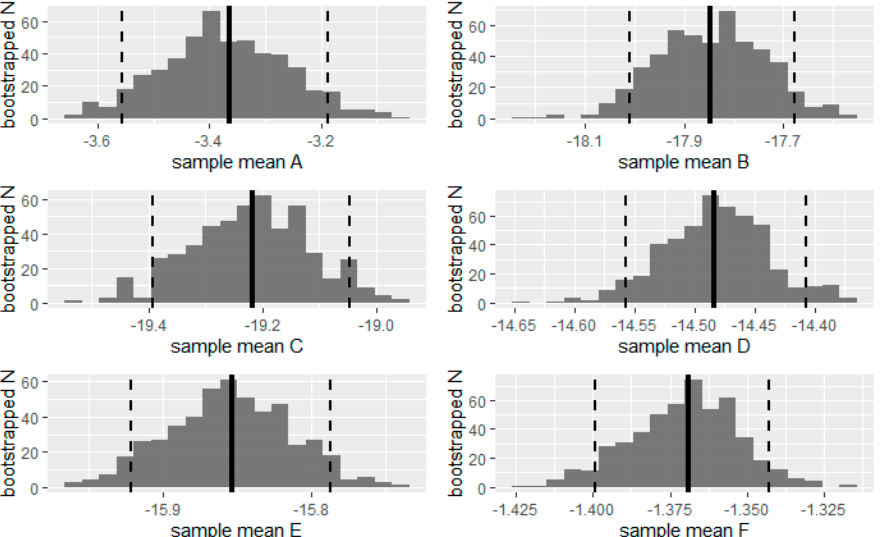
Figure A5. Histogram plots mean differences between each pair of observer profiles (( A ) garden-watcher vs beginner; ( B ) garden-watcher vs naturalist; ( C ) garden-watcher vs expert; ( D ) beginner vs naturalist; ( E ) beginner vs expert; ( F ) naturalist vs expert) obtained by 500 bootstraps of the original samples. Dotted lines are the confidence interval boundaries ( p = 0.05) and the central line is the initial sample